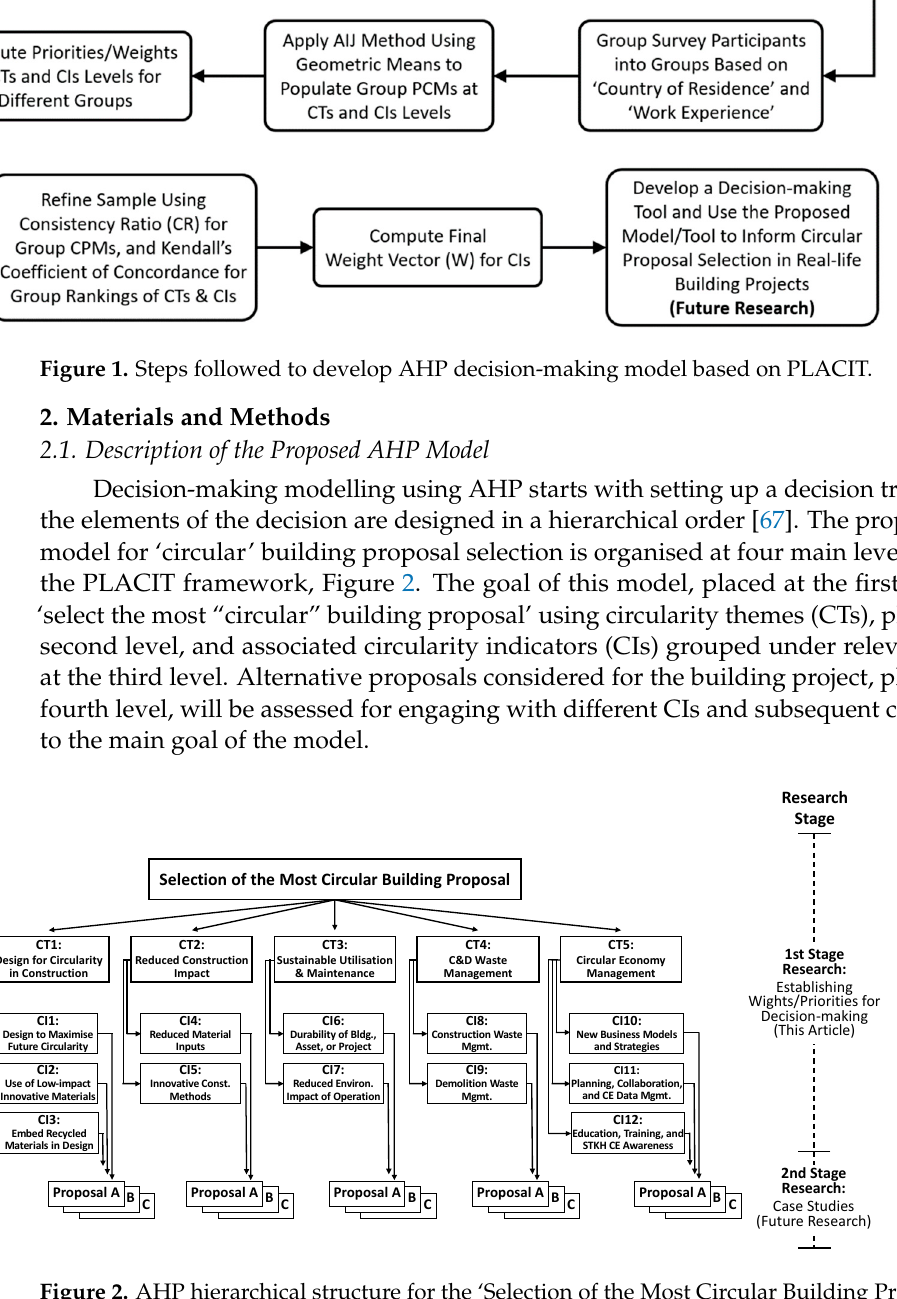
Figure 2. AHP hierarchical structure for the ‘Selection of the Most Circular Building Proposal’.